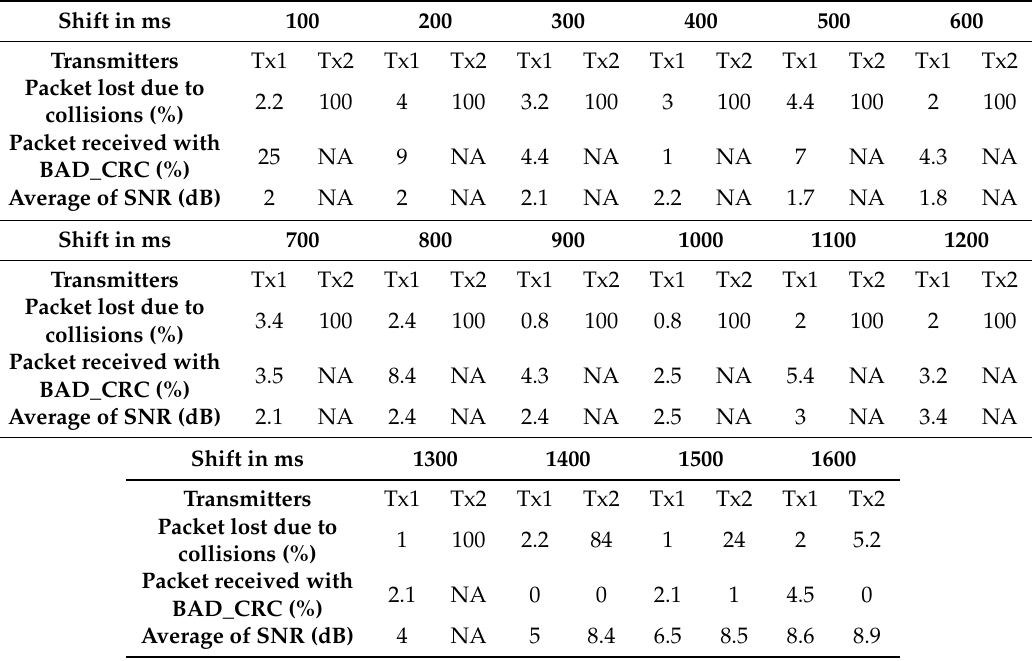
Table 2. Statistics for collided packets for the case when the interferer has the same RSSI as the interfered transmission for the first setting from Table 1. NA stands for Not Available.